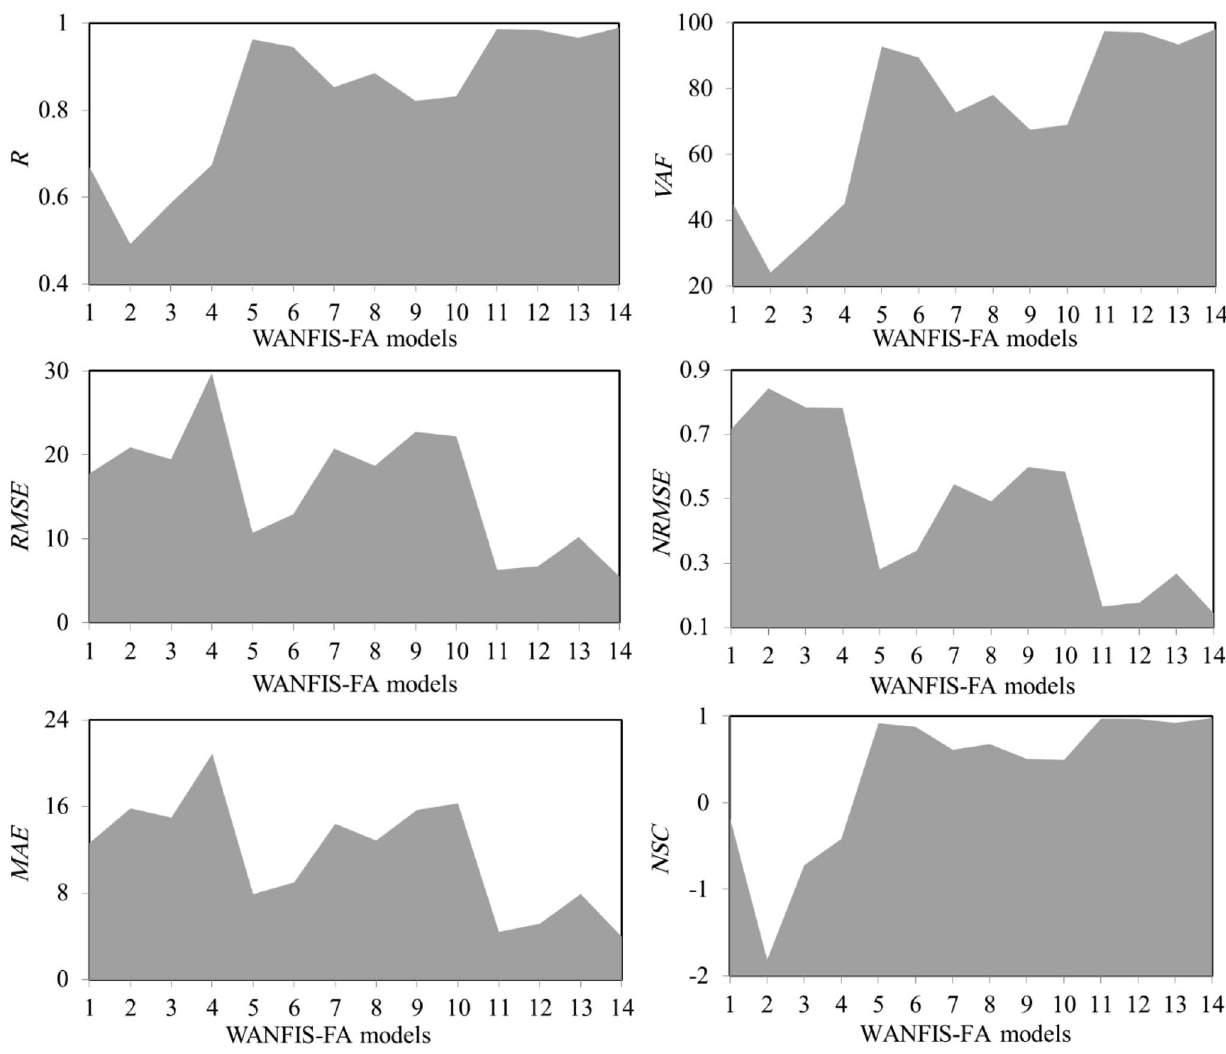
Fig. 11 Comparison of different statistical indices for all WANFIS-FA hybrid